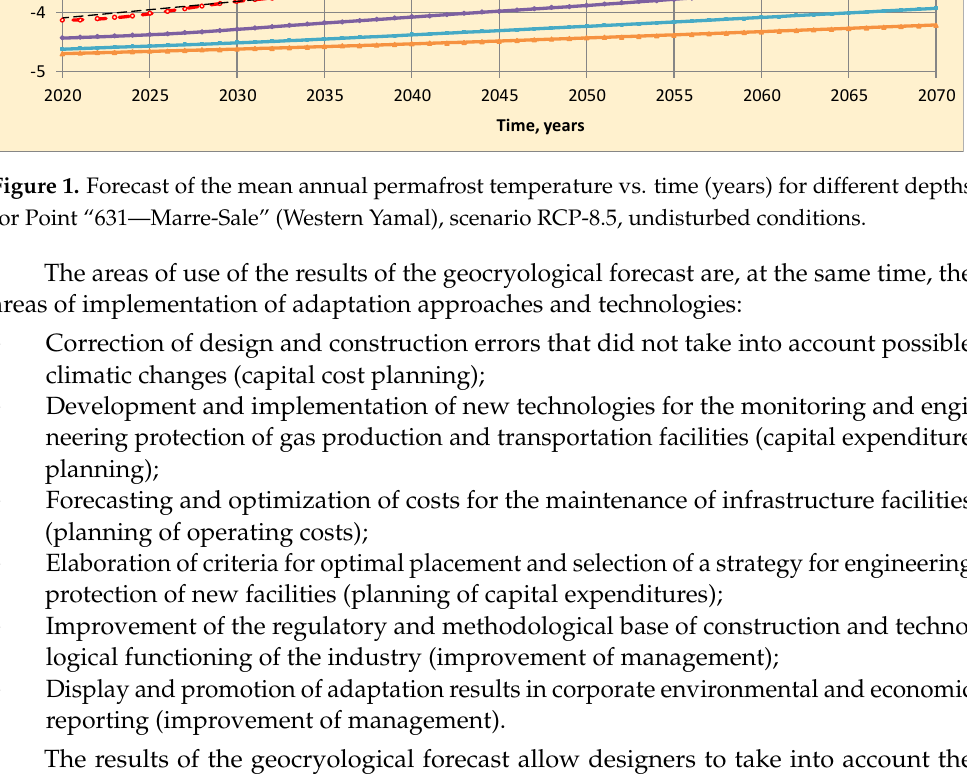
y = 0.028x - 60.643 R² = 0.9944